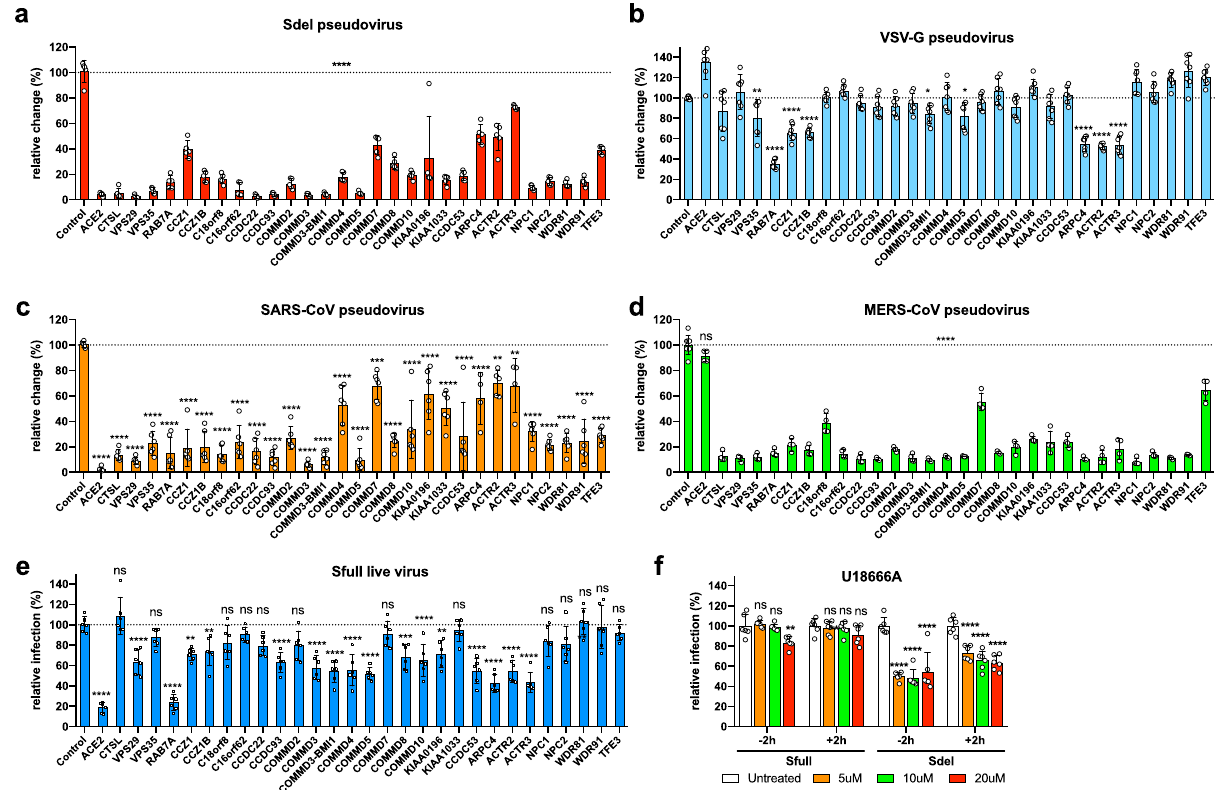
Fig. 3 Genes identi fi ed are required for the endosomal cell entry of SARS-CoV-2, SARS-CoV, and MERS-CoV. a – d The selected genes were veri fi ed for the infection by pseudovirus bearing the spike protein of SARS-CoV-2 Sdel strain ( a ), the the glycoprotein of vesicular stomatitis virus (VSV-G) ( b ), the spike protein of SARS-CoV ( c ), or the spike protein of MERS-CoV ( d ) (two experiments; n = 4 – 11; one-way ANOVA with Dunnett ’ s test; mean ± s.d.). One representative sgRNA per gene was used in A549-ACE2 cells. e The genes selected were veri fi ed for the infection by the SARS-CoV-2 Sfull live virus (two experiments; n = 6; one-way ANOVA with Dunnett ’ s test; mean ± s.d.). f Effect of NPC1 inhibitor U18666A on virus infection. Cells were treated with U18666A at the indicated concentrations 2 h prior to or 2 h post infection by Sfull or Sdel live virus. The viral N-positive cells were calculated (two experiments; n = 6; one-way ANOVA with Dunnett ’ s test; mean ± s.d.). Data shown were normalized to the controls of individual experiments. ** P < 0.01; *** P < 0.001; **** P < 0.0001; n.s. not signi fi